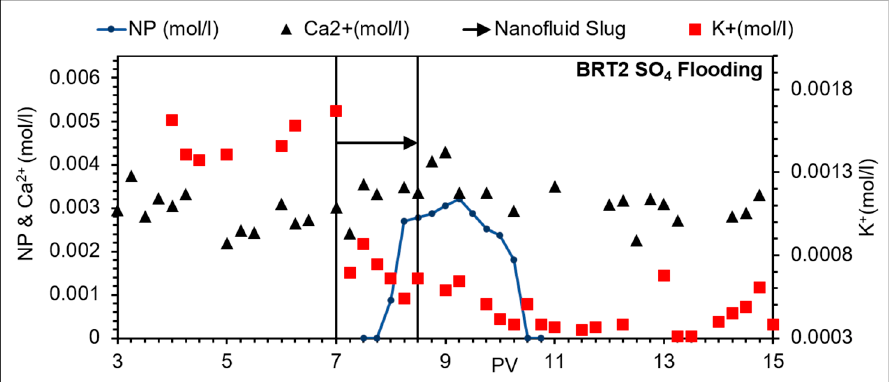
Figure 8. Effluent ion composition, BRT2; SO 4 brine flooding. Figure 8. E ffl uent ion composition, BRT2; SO 4 brine flooding.